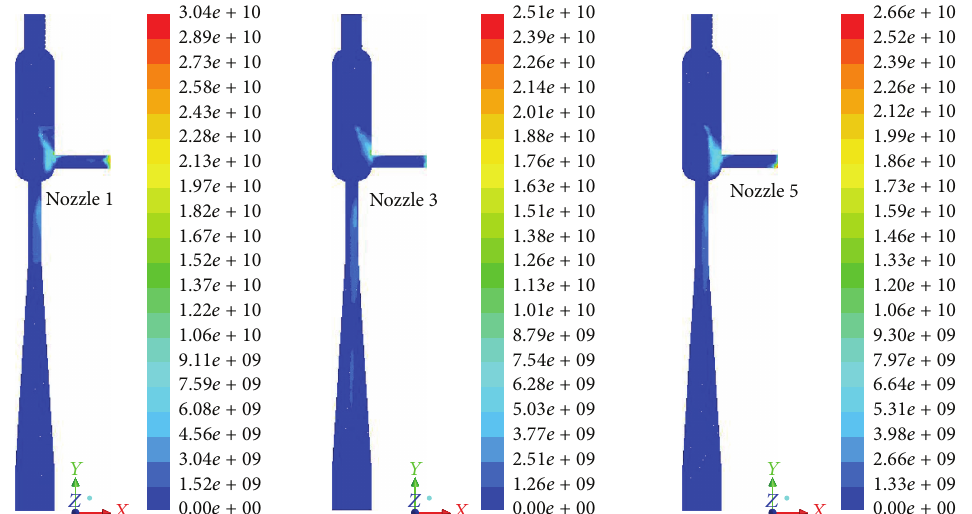
Figure 11: Contour of the number density of bin fraction 10 for nozzles 1, 3, and 5.